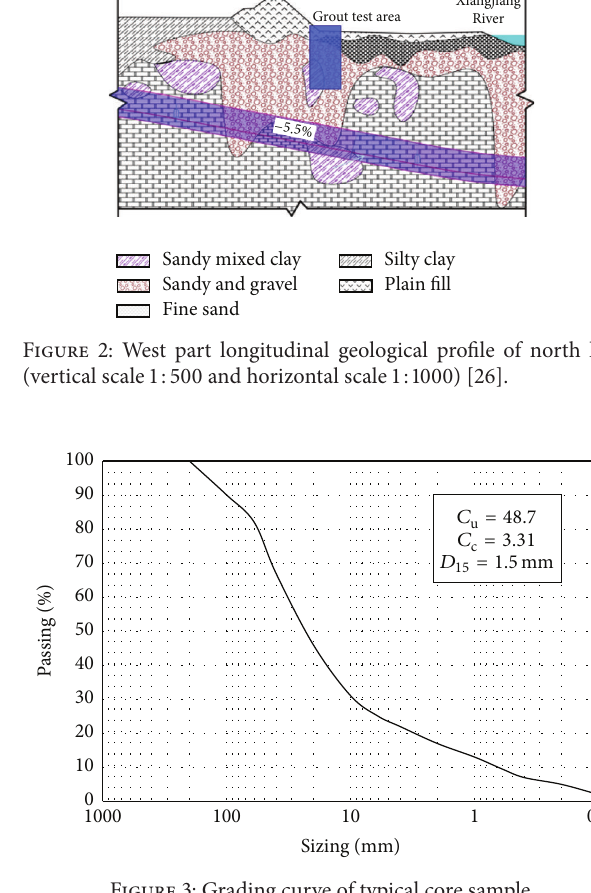
Figure 3: Grading curve of typical core